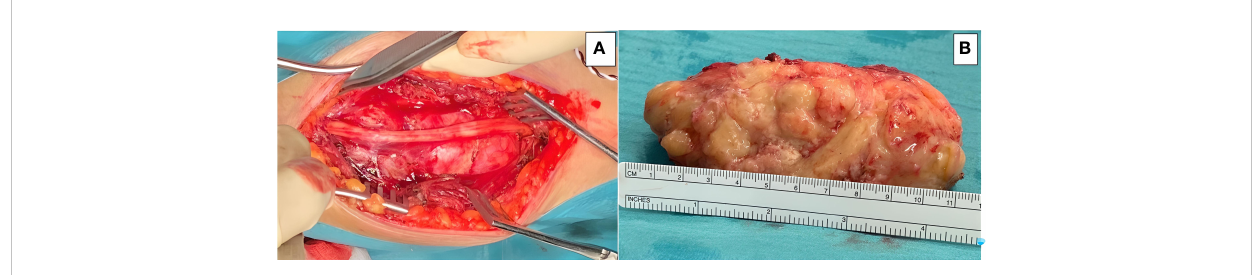
FIGURE 2 Microsurgical resection of the tumor was accomplished, and the lesion was removed enbloc: (A) The main trunk of the median nerve is seen running over the tumor surface. (B) Gross appearance of the tumor after resection, placed next to a ruler for